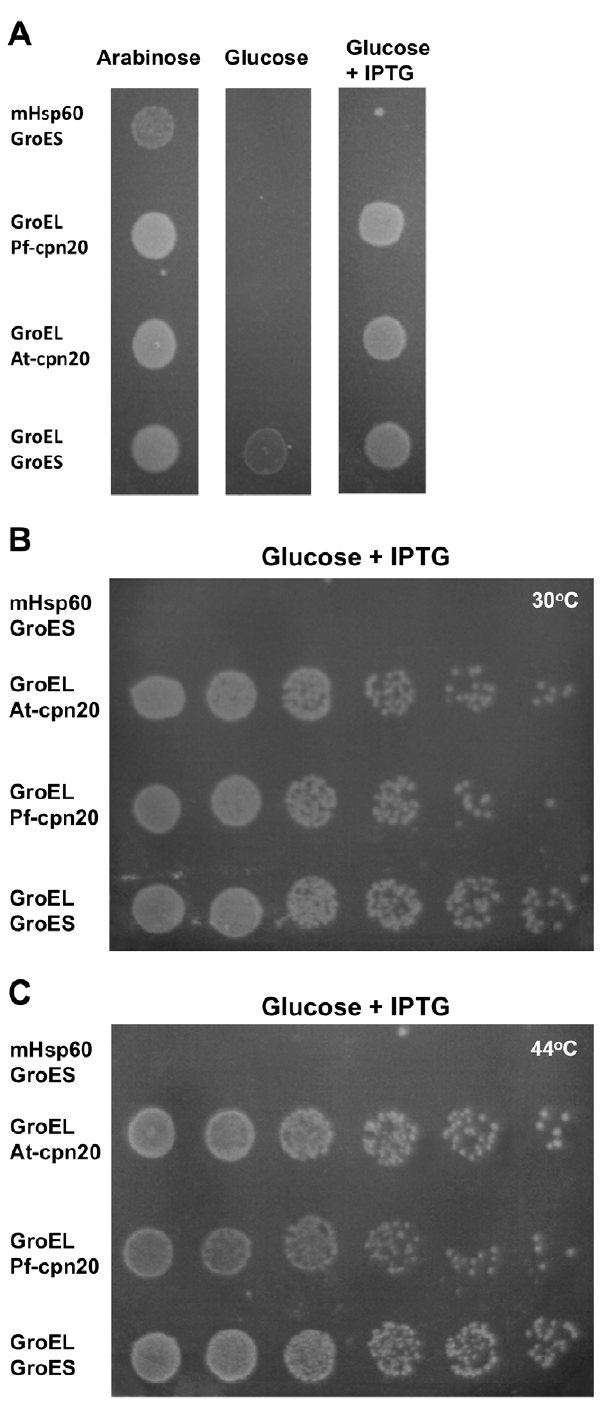
Figure 3. Pf-cpn20 successfully replaces the function of GroES in E.coli . Complementation assays were carried out in a strain of E. coli , MGM100, in which expression of endogenous chaperonins (GroEL- GroES) was under strict control of the pBAD promoter. (A) Various controls for the in vivo system at the indicated growth conditions (10 2 2 dilution shown). (B and C) Ten-fold-serial dilutions (10 2 2 to 10 2 7 shown) of E. coli strain MGM100 harboring plasmid pOFX containing GroEL and the indicated co-chaperonin, grown on agar plates in the presence of glucose and IPTG, but no arabinose: B) at 30 u C C) at 44 u C.